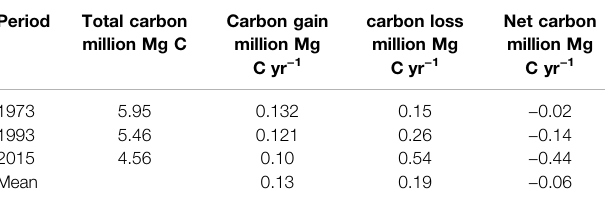
TABLE 2 | Statistics of total carbon stock, mean annual increment, carbon gain, carbon loss, and net carbon over different period.S.